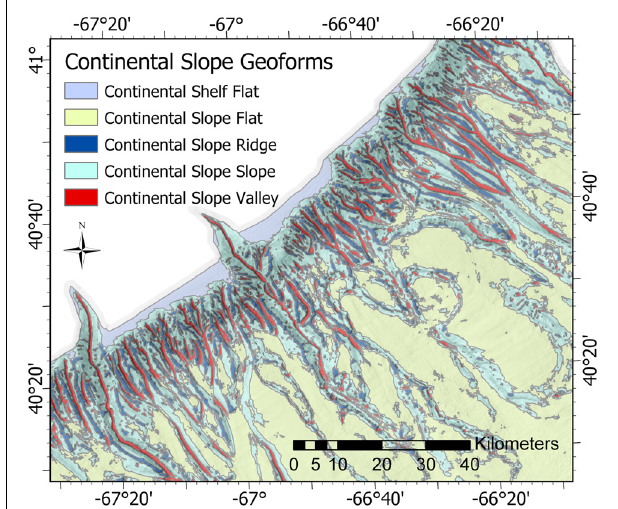
FIGURE 8 | Prominent submarine canyon features on the continental slope in the Mid-Atlantic as classified by CMECS geoforms. This geoform map clearly highlights the extensive network of gullies and submarine canyons that are a signature feature of the region. A hillshade layer was computed from the bathymetry and is shown with partial transparency to provide depth and context to the